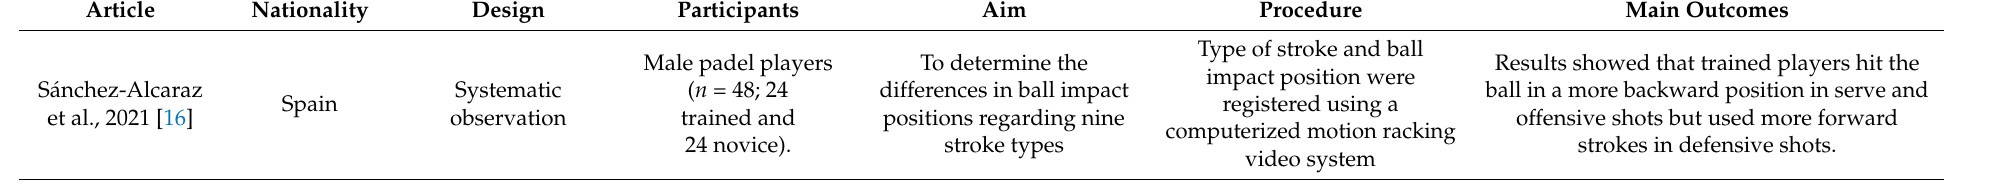
Table 1. Main characteristics of the included